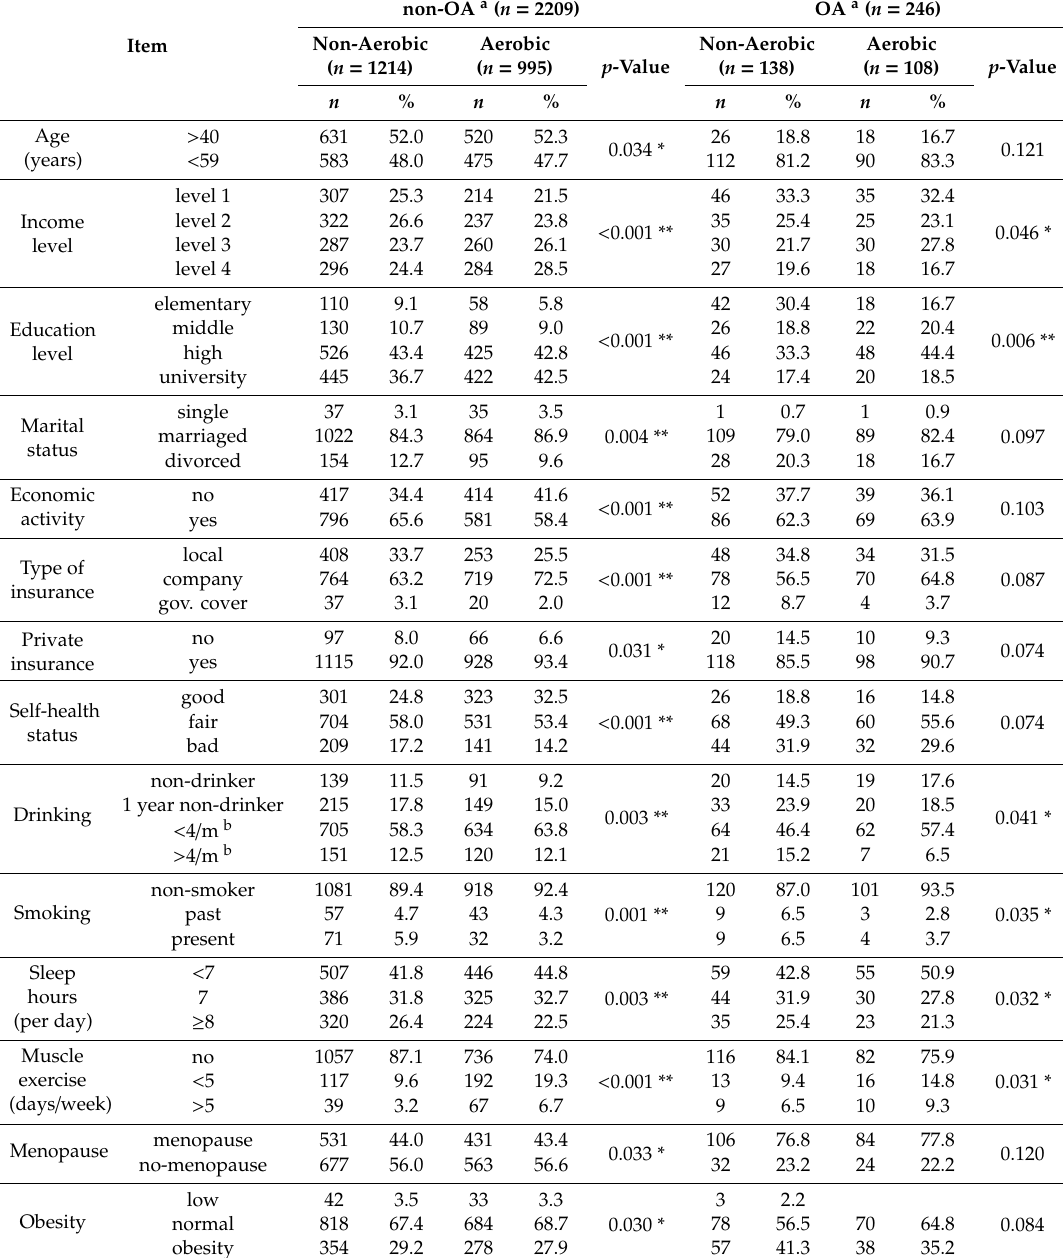
Table 1. Characteristics of subjects included